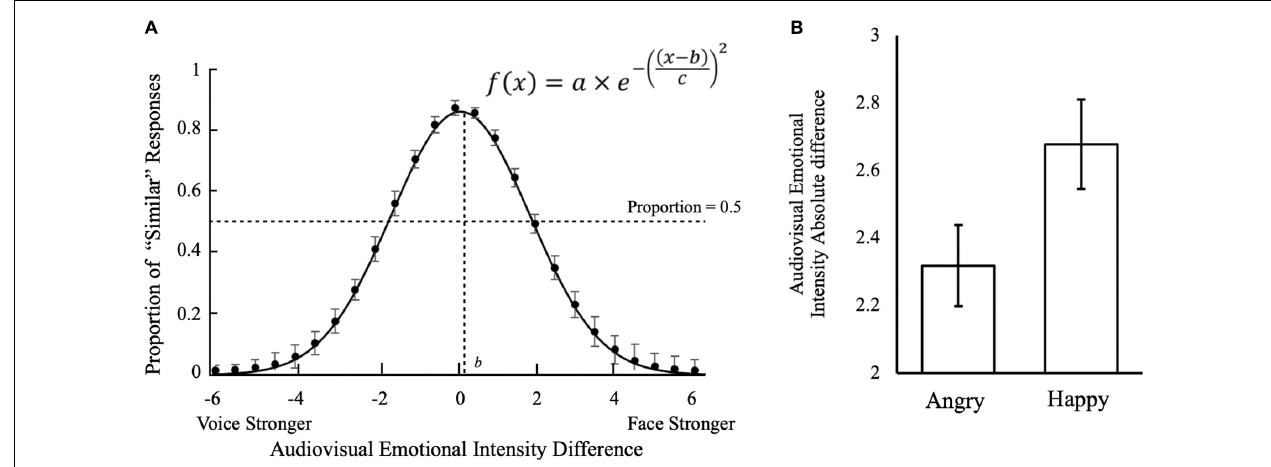
FIGURE 3 | Audiovisual emotion intensity differences in multisensory integration. (A) Effect of audiovisual emotion intensity difference on judgment that audiovisual stimuli were similar in emotional intensity. Positive audiovisual emotional intensity differences indicate the emotional intensity of faces to be stronger than voice; negative differences indicate voices to be stronger than faces. The estimated parameters for the Gaussian distribution: a = 0.86, 95% CI = [0.73, 1.0]; b = 0.21, 95% CI = [0.1, 0.23]; c = 0.88, 95% CI = [0.72, 1.04]. (B) Face-voice emotional intensity absolute difference cut-off for differentiating Similar trials and Not Similar trials by emotion conditions. Optimal cut-offs were obtained from each participant using ROC analysis by maximizing the Youden index ( J = Sensitivity + Specificity − 1). The error bars indicate standard errors of mean (SEM) in (A,B) .